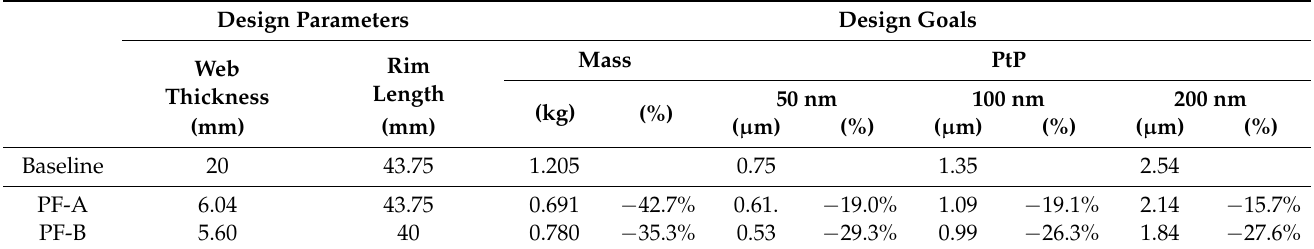
Table 3. Optimal design Results.